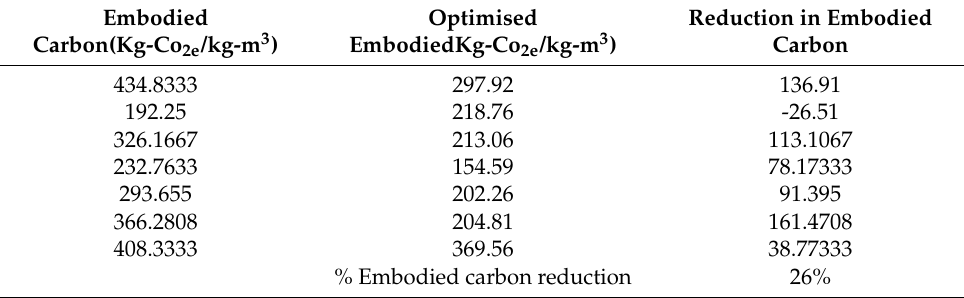
Table 15. Concrete mix optimisation extracted from [35].